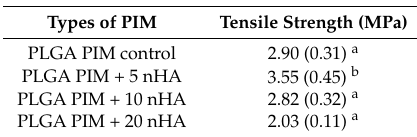
Table 1. Means (Standard deviations) of tensile strength of single layer phase inversion membrane (PIM) with different composition ( n = 6) *.